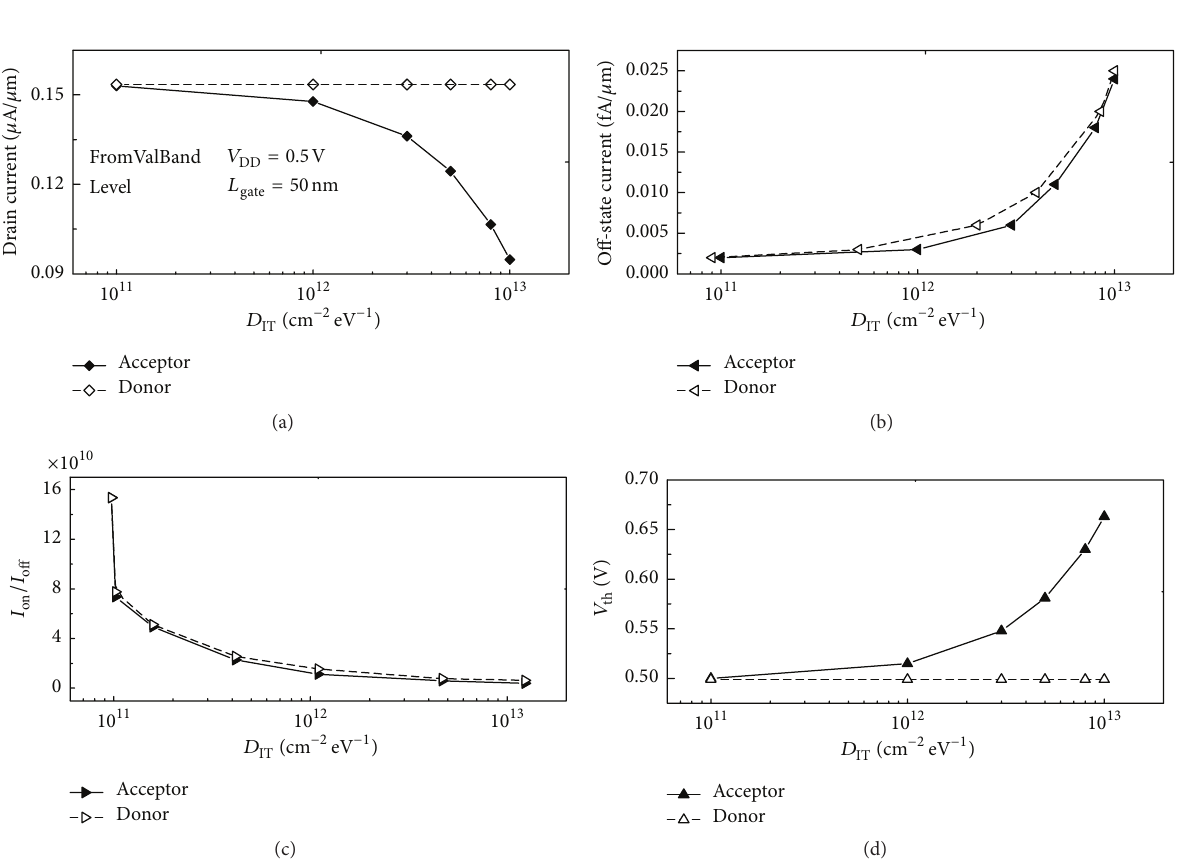
= 0 V, 𝑉 at 𝑉 off GS